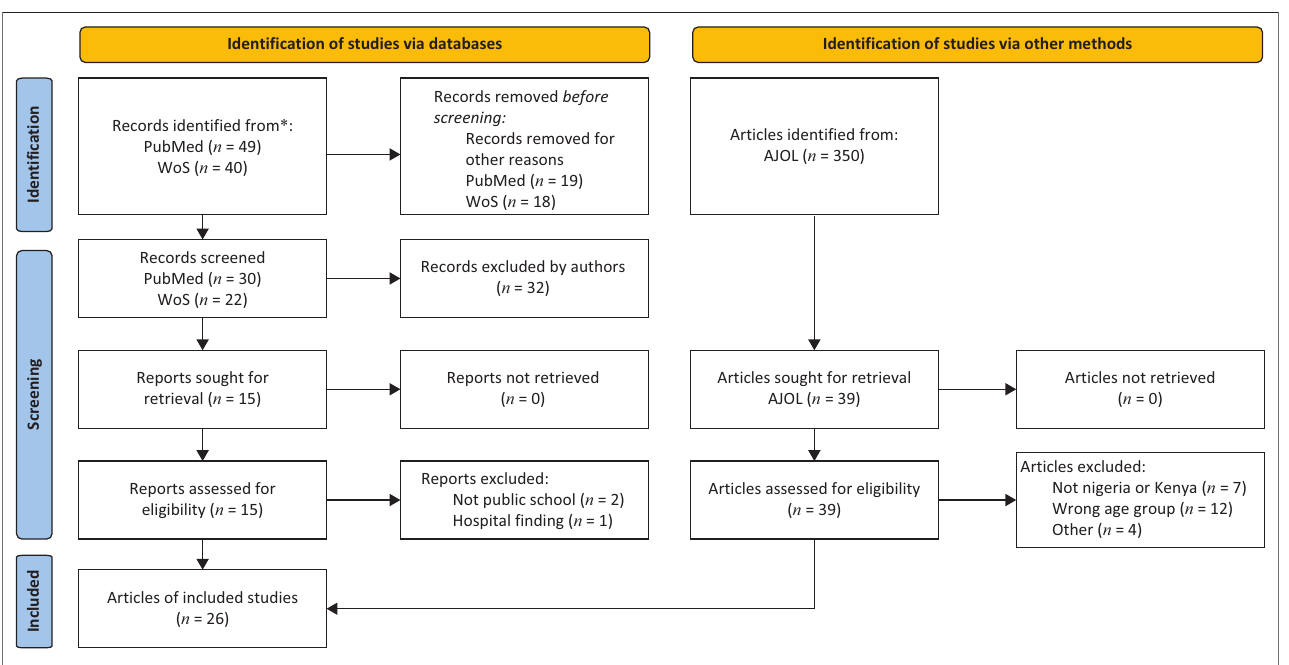
Articles excluded: Not nigeria or Kenya ( n = 7) Wrong age group ( n = 12) Other ( n =